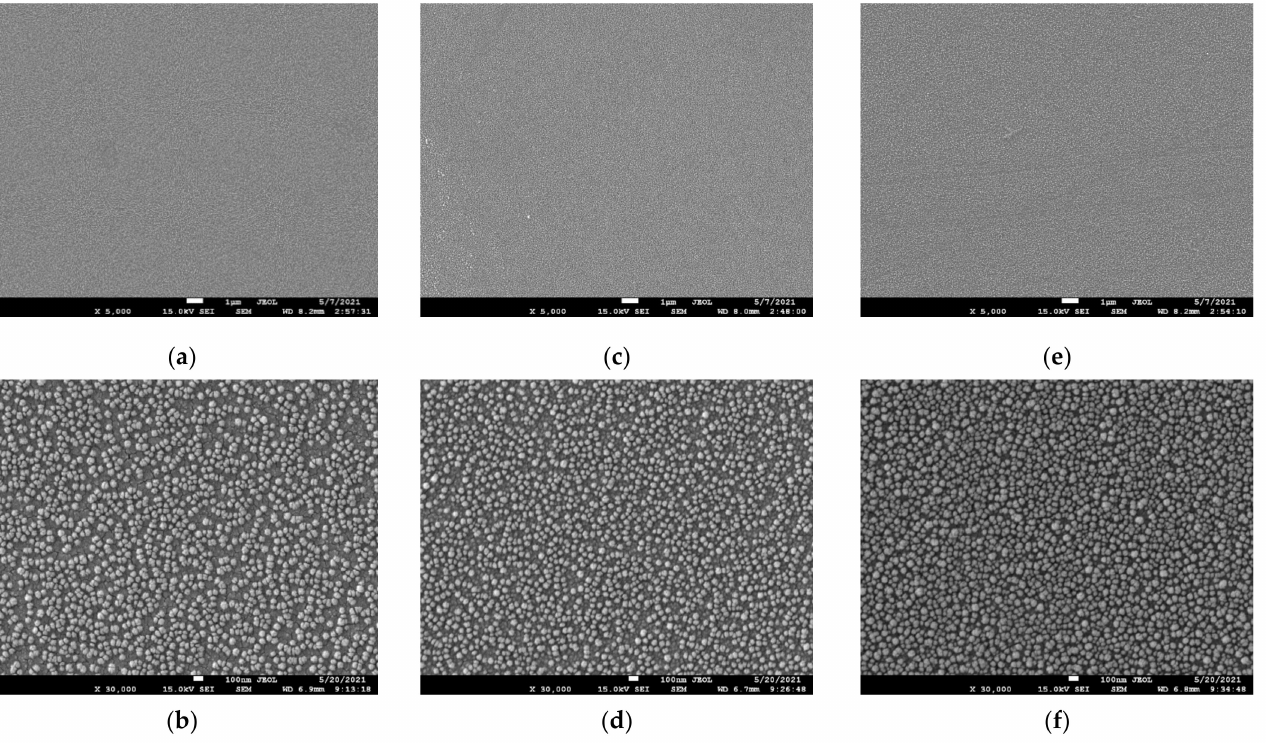
Figure 8. Surface of the SEM images of the SiO 2 samples: without etching of ( a ) × 5000, ( b ) × 30,000, at 400 W discharge power and 270 mTorr process pressure with NF 3 plasma of ( c ) × 5000, ( d ) × 30,000 and F 3 NO plasma of ( e ) × 5000 and ( f ) ×